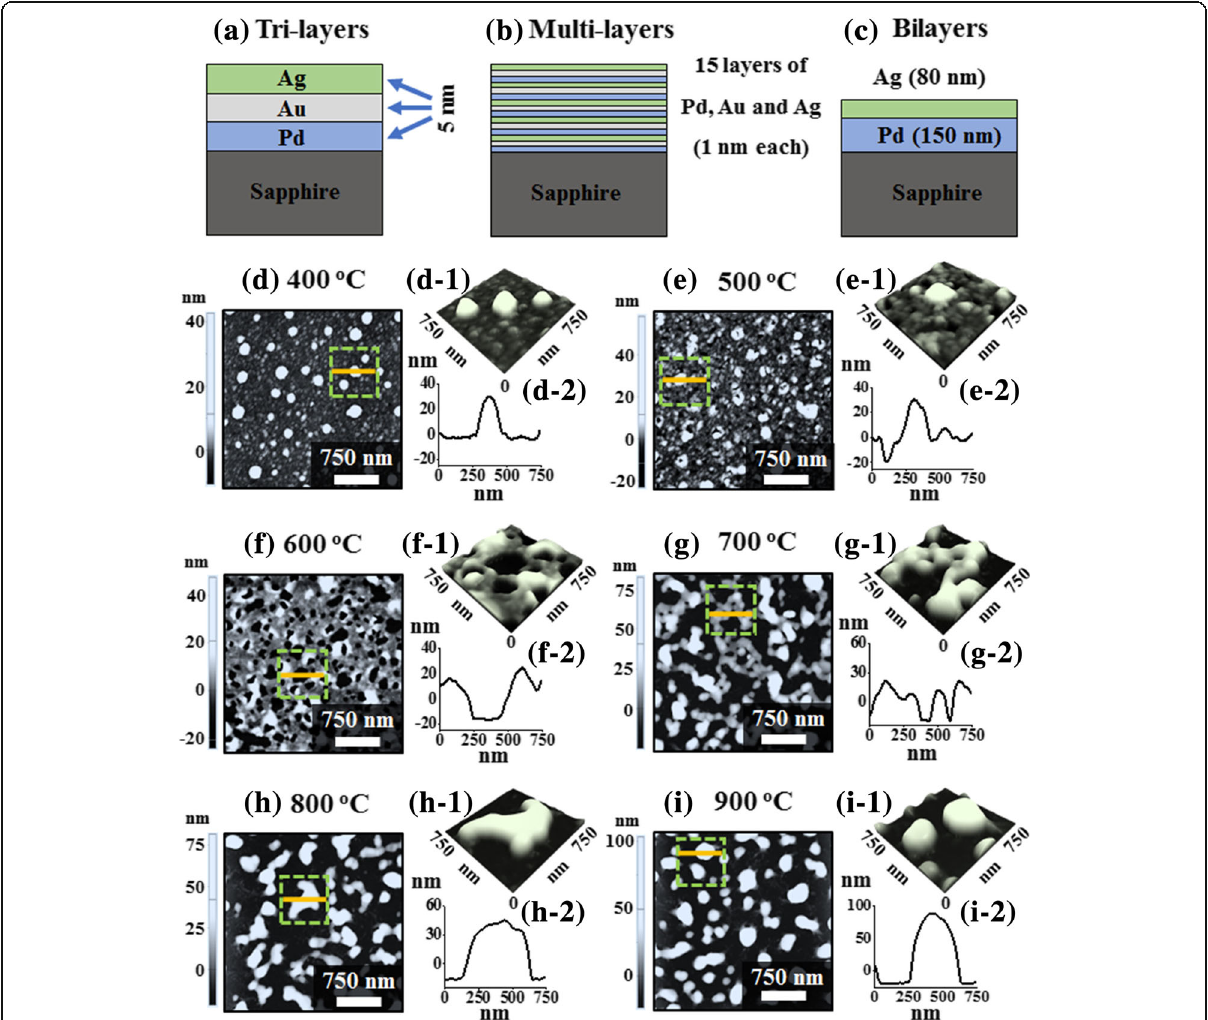
Fig. 1 Schematic description of layer deposition. a 15 nm of Pd/Au/Ag with 5 nm each layer (tri-layers). b 15 nm of Pd/Au/Ag (15 layers) with 1 nm each (multi-layers). c Pd 150 nm /Ag 80 nm bi-layer deposition (bi-layers). d – i Evolution of tri-metallic PdAuAg NPs between 400 and 900 °C for 450 s on sapphire (0001). This set is based on the 15 nm of Pd/Au/Ag with 5 nm each layer. d – i AFM top-views (3 × 3 μ m 2 ). d-1 – i-1 Magnified AFM side views (750 × 750 nm 2 ). d-2 – i-2 Cross-sectional line